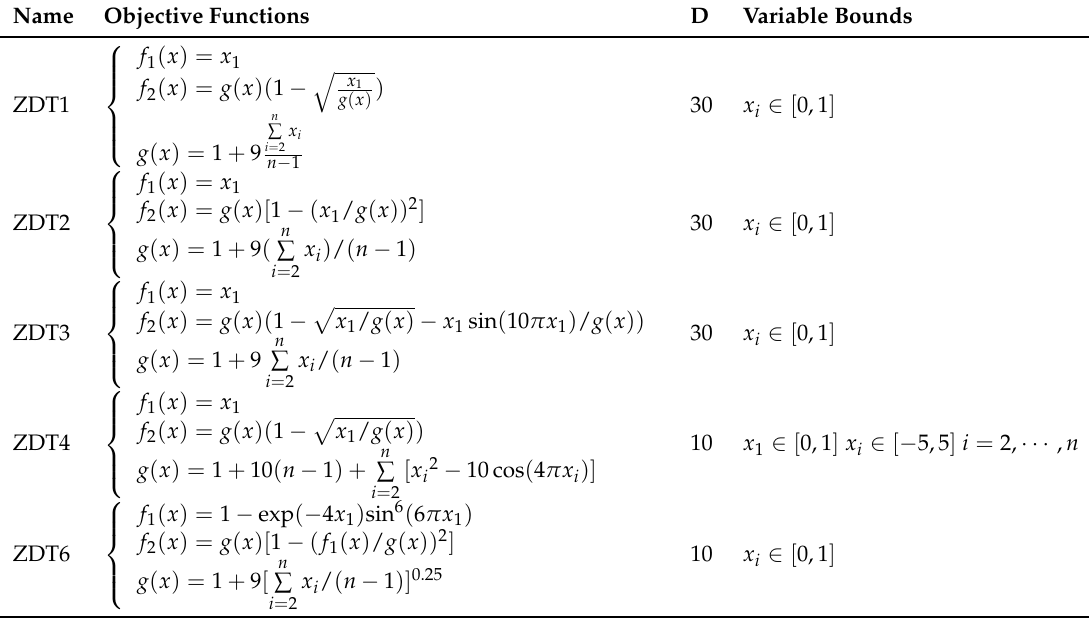
Table 2. Benchmark function—ZDT.